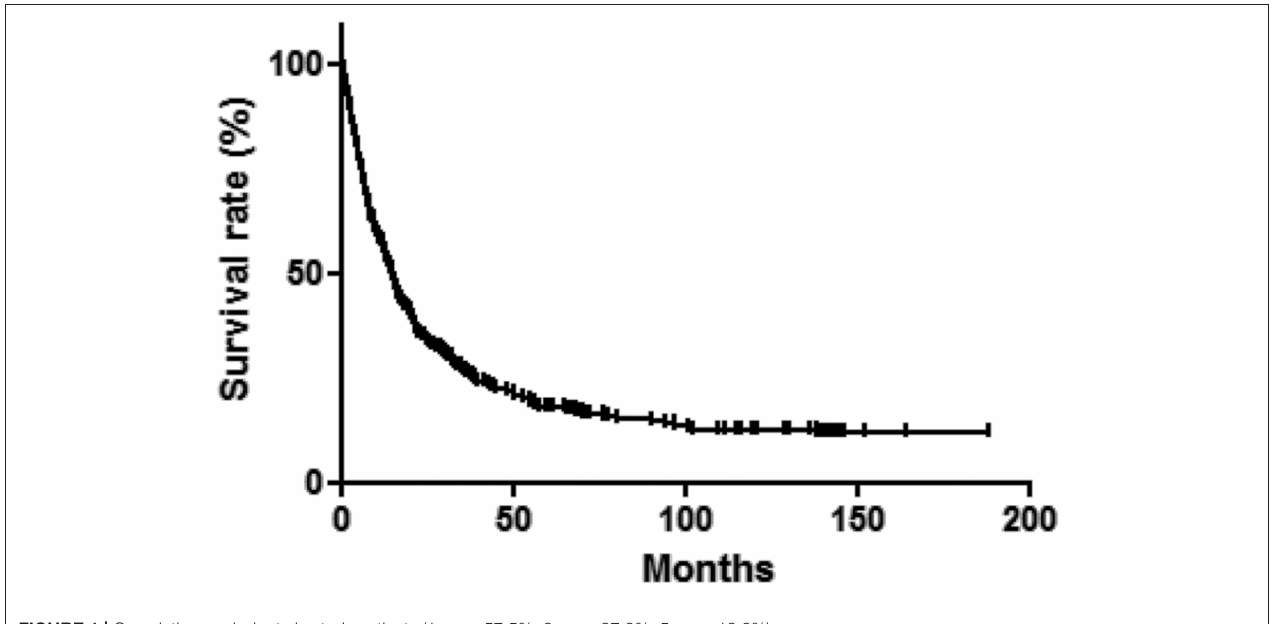
FIGURE 1 | Cumulative survival rate in study patients (1-year: 57.5%, 3-year: 27.2%, 5-year: 18.2%).